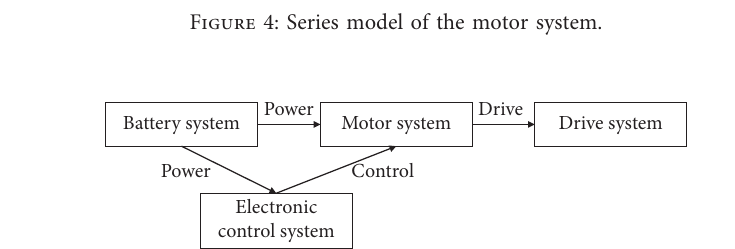
Figure 5: Relationships among the subsystems of the electric vehicle.